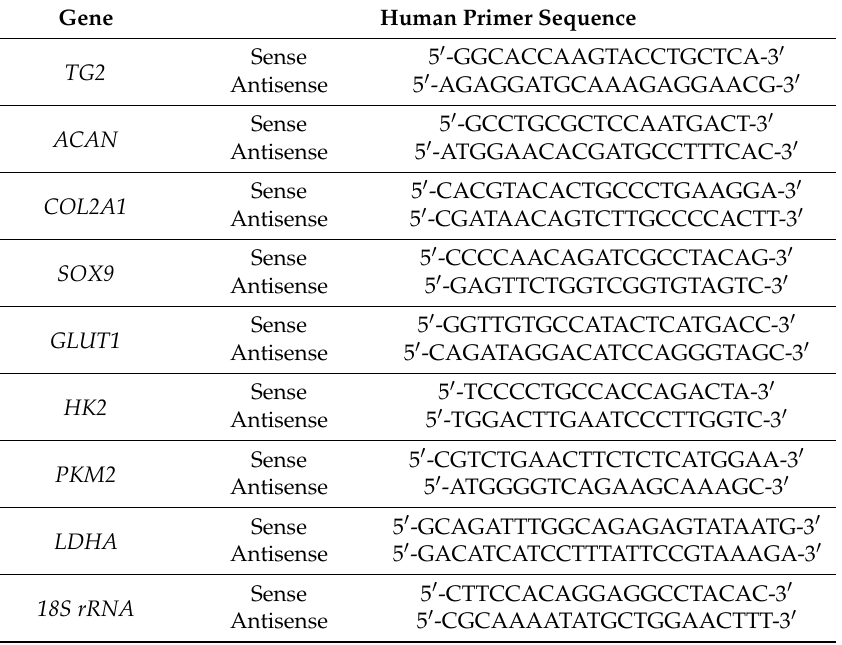
Table 1. Nucleotide sequences of primer pairs for real-time PCR. Gene Human Primer Sequence